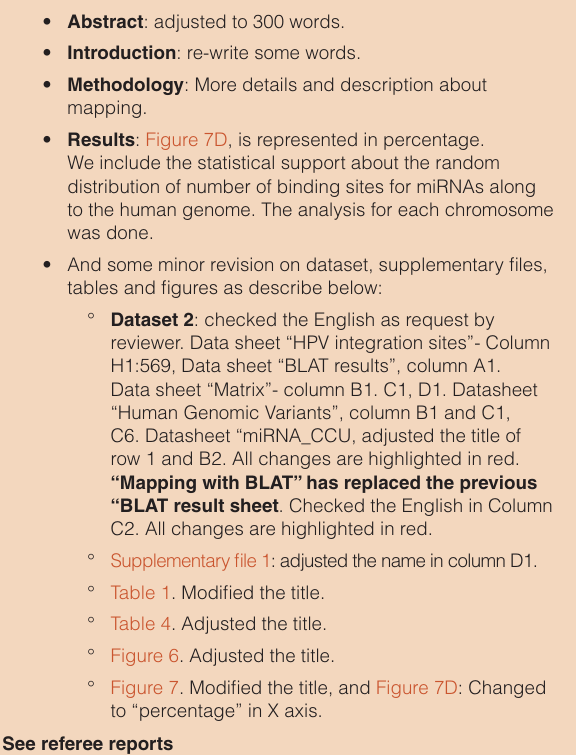
° Table 1. Modified the title. ° Table 4. Adjusted the title. ° Figure 6. Adjusted the title. ° Figure 7. Modified the title, and Figure 7D: Changed to “percentage” in X